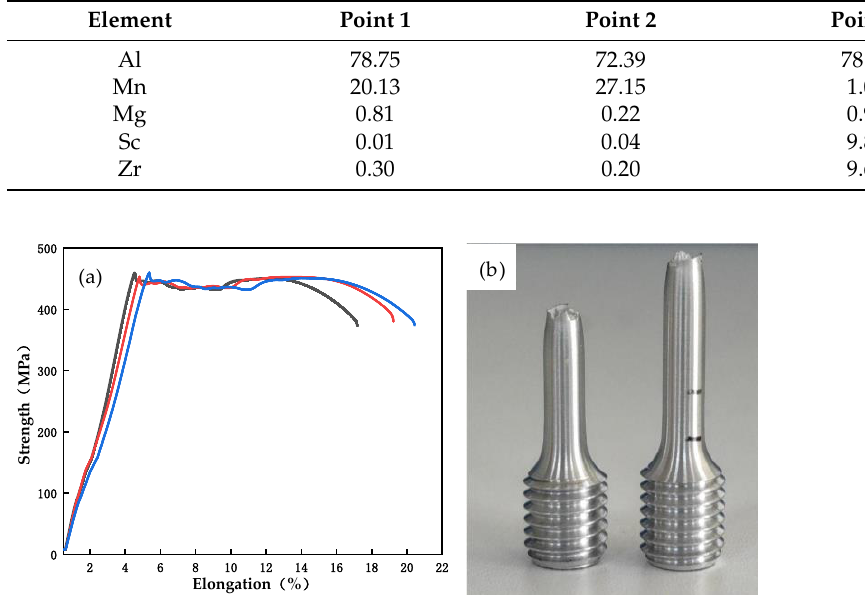
Figure 9. Mechanical performance analysis: ( a ) Engineering stress-strain curves of the as-deposited samples; ( b ) Tensile fractural sample.